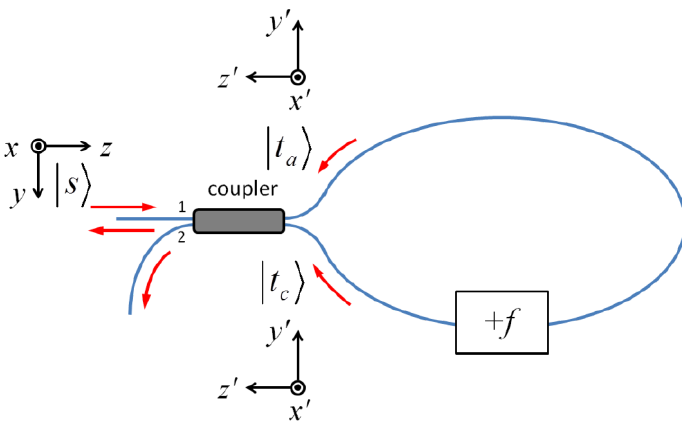
Figure 13. Input and output polarization of a frequency-shifted Sagnac interferometer. The coordinate system for the input polarization state s is x - y - z , and the coordinate system for the output states t and t is x  - y  - z  a c